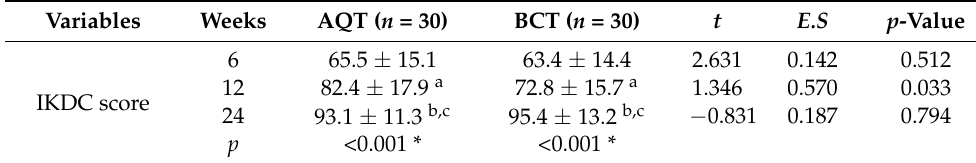
Table 3. Subjective knee score according to group and weeks.